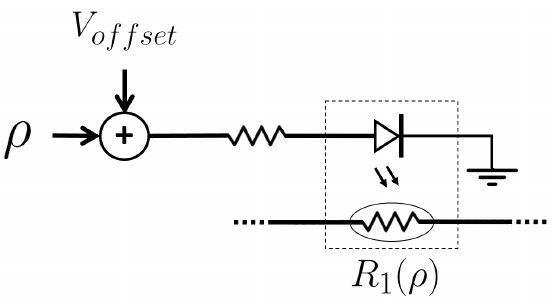
Figure 9. TIF-controlled resistor implemented by means of a photoresistive opto-isolator. The schematic of both summing amplifier and double integrator circuit is not shown for simplicity.